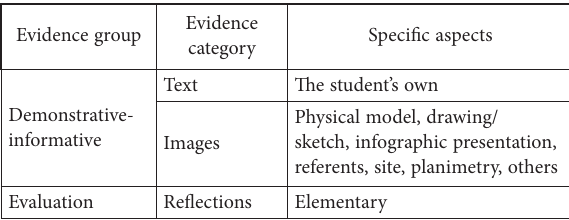
Table 8. Specific aspects of the evidences present in the e-portfolio (source: Authors, 2019) Evidence group